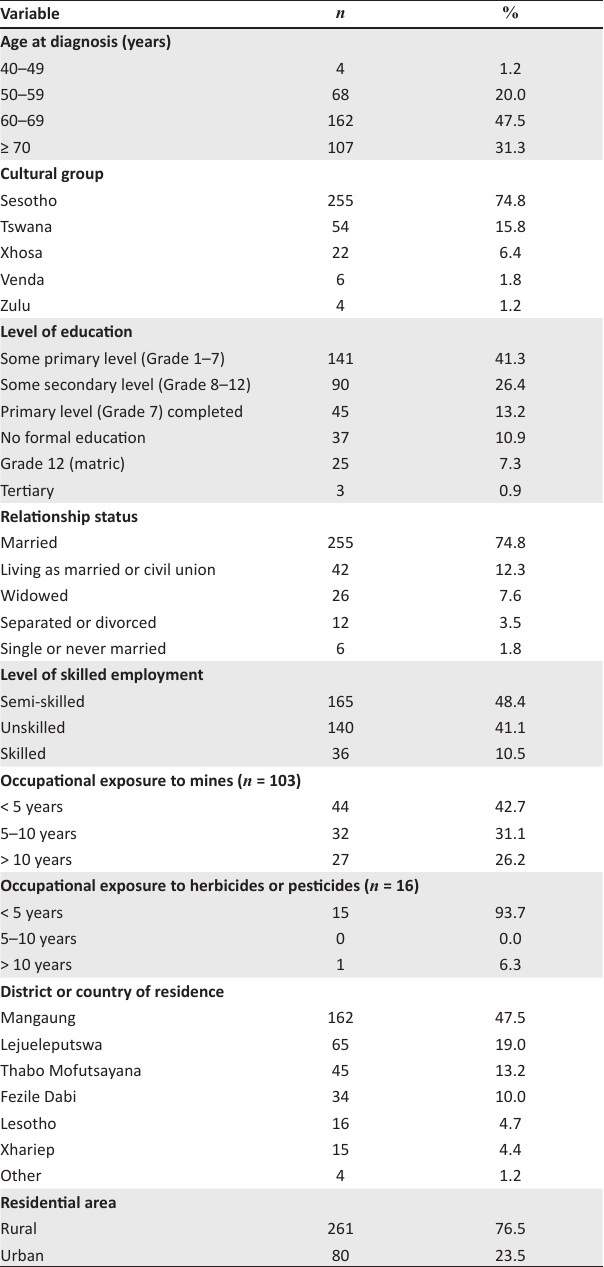
TABLE 1: Sociodemographic and background characteristics of the participants ( n = 341).